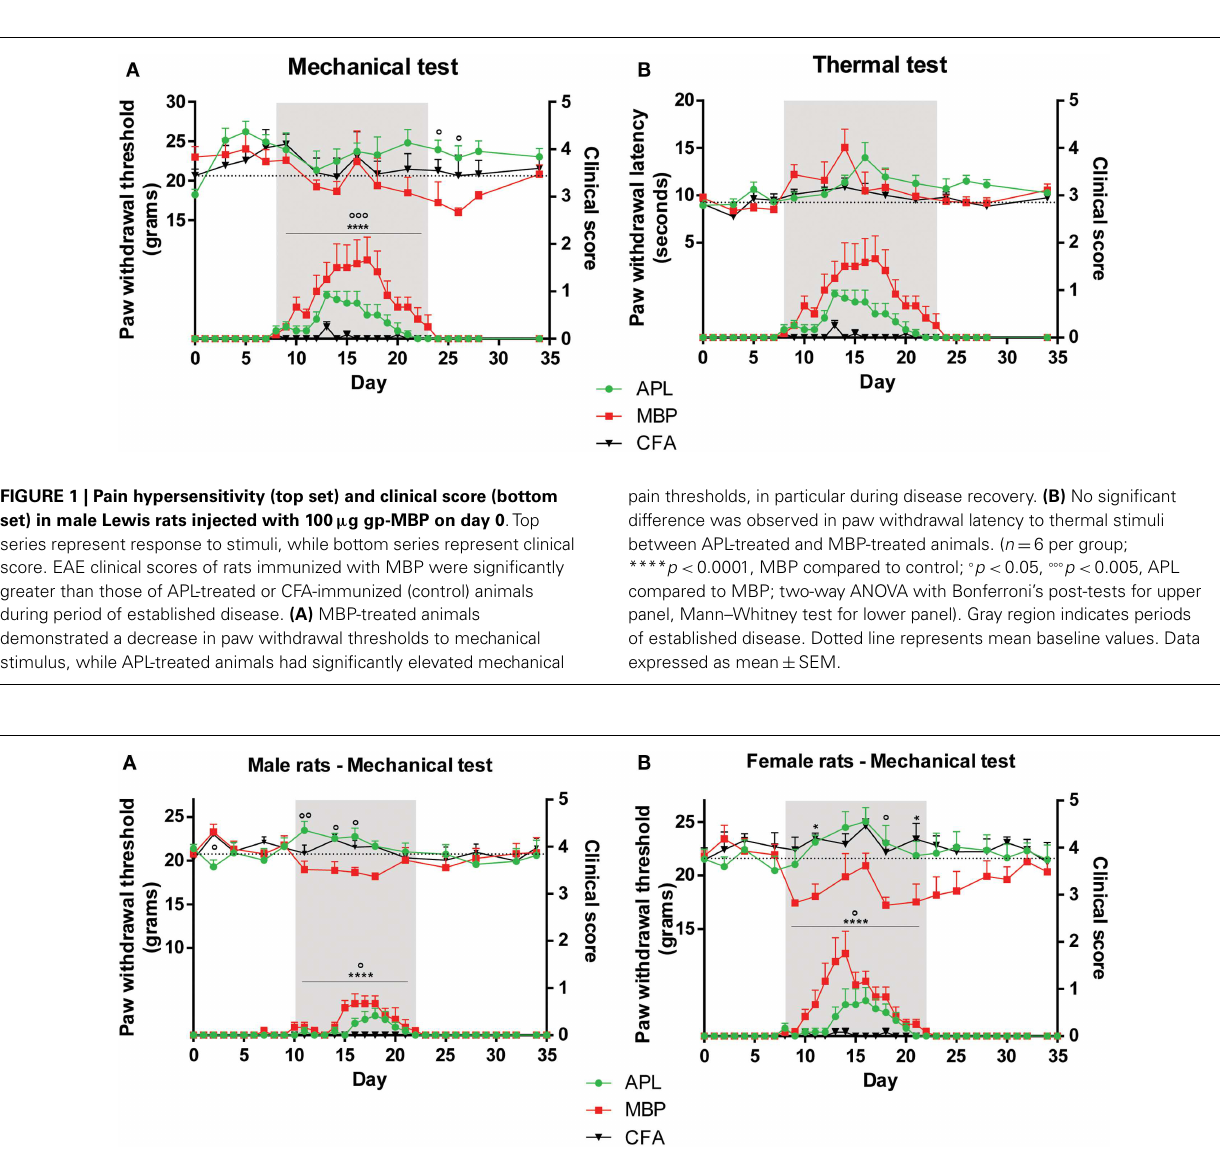
FIGURE 2 | Changes in mechanical sensitivity (top set) in male and female Lewis rats inoculated with 50 µ g gp-MBP on day 0 compared to clinical scores (bottom set) . In both males and females, EAE clinical scores of rats immunized with MBP were significantly greater than those of APL-treated or CFA-immunized (control) animals during period of established disease. (A) In males, APL conferred significant increase in mechanical threshold compared to MBP-treated rats on day 11, 14, 16. (B) In females,